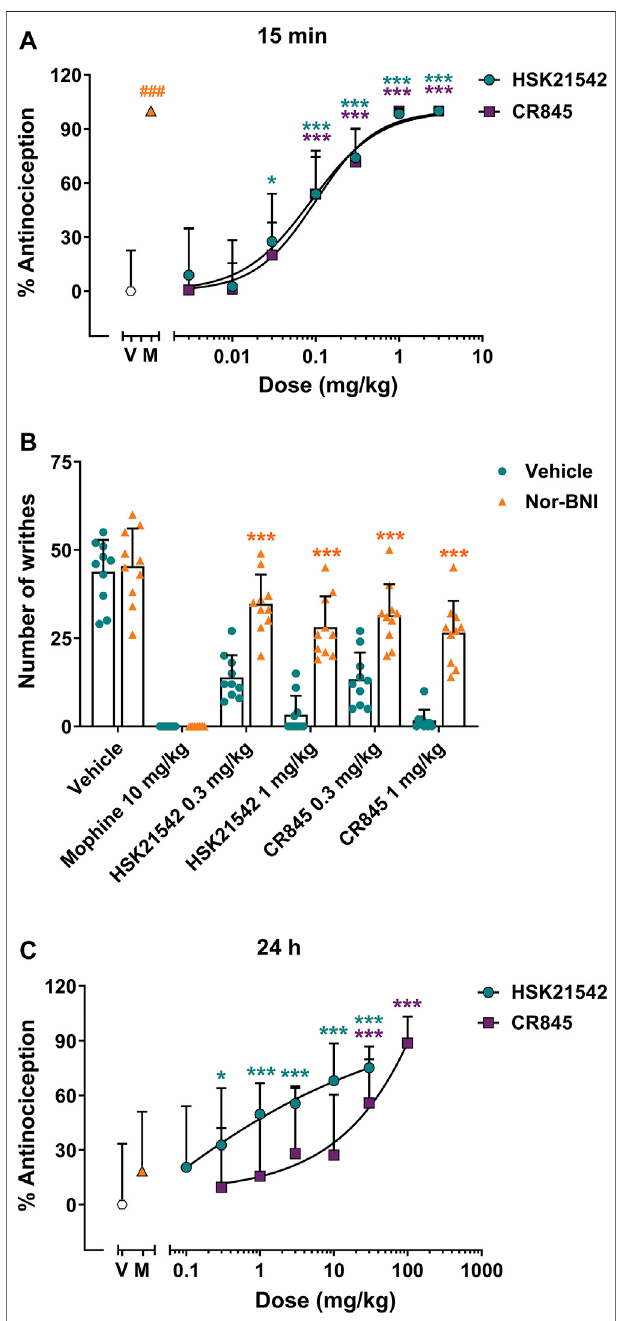
FIGURE 3 | Antinociceptive effects of HSK21542 and CR845 in acetic acid-induced writhing response in mice. (A) The writhing tests were conducted at 15 min post-dosing. (B) Nor-binaltorphimine (Nor-BNI, 32 mg/kg, s.c.), a KOR antagonist, was given at 24 h before drug administration, and the antinociceptive effects of HSK21542 and CR845 were examined at 15 min post-dosing. (C) The writhing tests were performed at 24 h post-dosing. Data are presented as means ± SD ( n (cid:1) 10/group). (A, C) * p < 0.05, *** p < 0.001 vs. vehicle, one-way ANOVA followed by Dunnett ’ s test; (B) *** p < 0.001 vs. vehicle, Student ’ s t-test; ### p < 0.001 vs. vehicle, Mann-Whitney test. V, Vehicle; M, Morphine (10 mg/kg, a positive